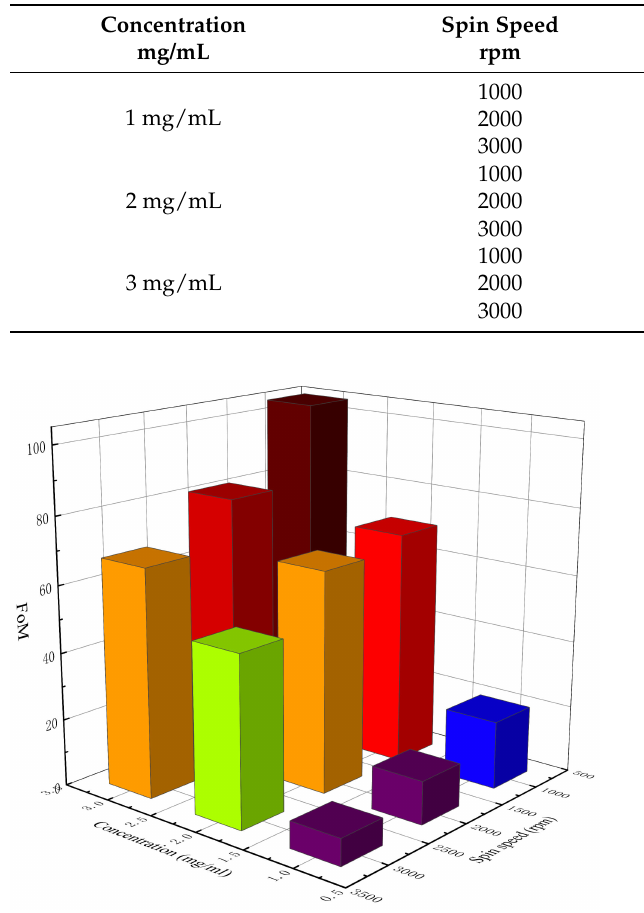
Figure 5. The 3D histogram of the variation in FoM with concentration and spin